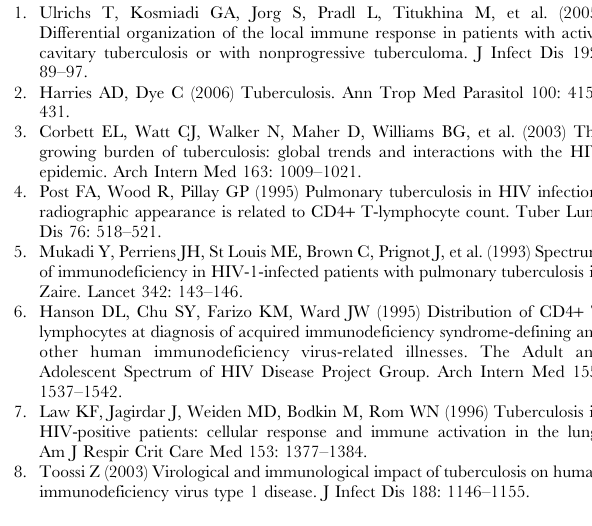
Figure S2 Changes in T cell frequencies in the peripheral lymph nodes of co-infected macaques. Peripheral (inguinal or axillary) lymph node biopsies were performed on co-infected monkeys at 0, 4, 12, and 24 weeks post SIV inoculation. Numbers represent early (1207, 1407, 2407) and late (1807, 1907, 3007, 10405) reactivator. Figure S3 T cell activation markers increase following SIV infection. Changes in the expression of early (CD69) and late (CD29) activation markers are represented in CD4 or CD8 peripheral T cells over time. Found at: doi:10.1371/journal.pone.0009611.s003 (8.63 MB TIF) Table S1 Virus and bacterial burden in uninvolved and involved